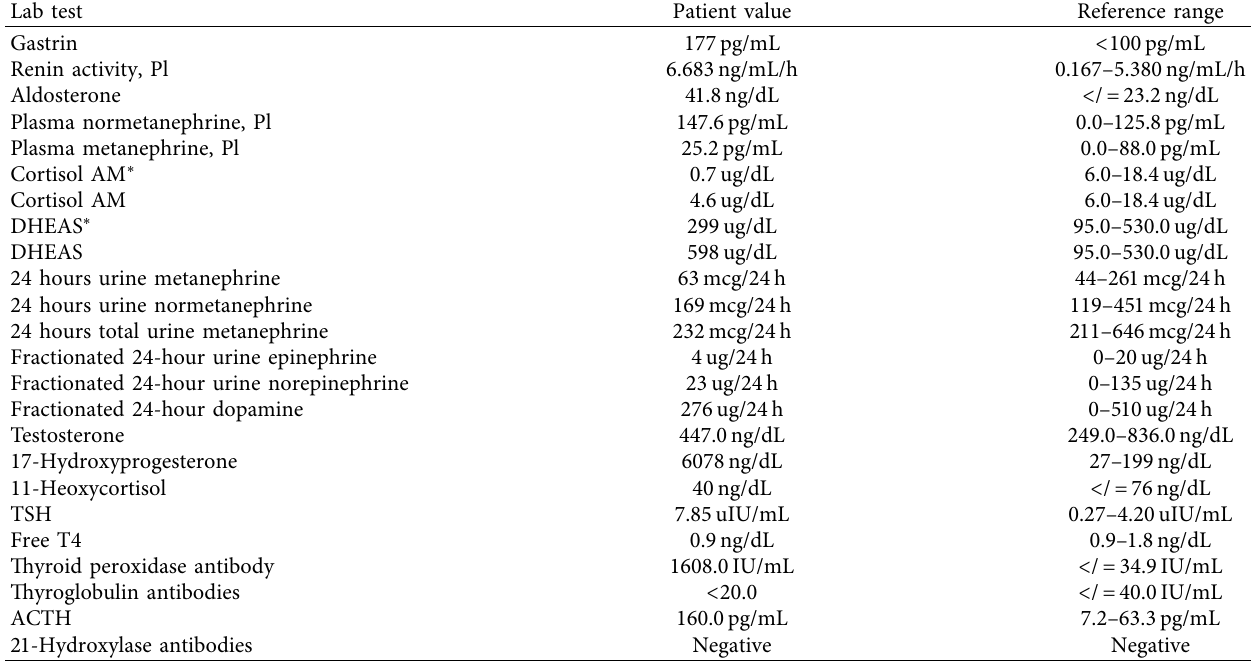
Table 1: Endocrinologic laboratory